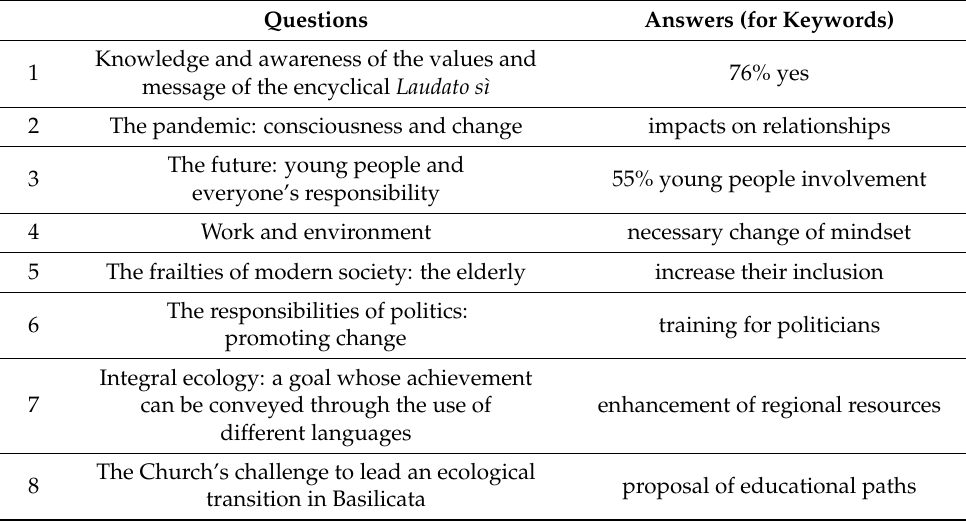
Table 2. Thematic nuclei of the questionnaire addressed to parishes.